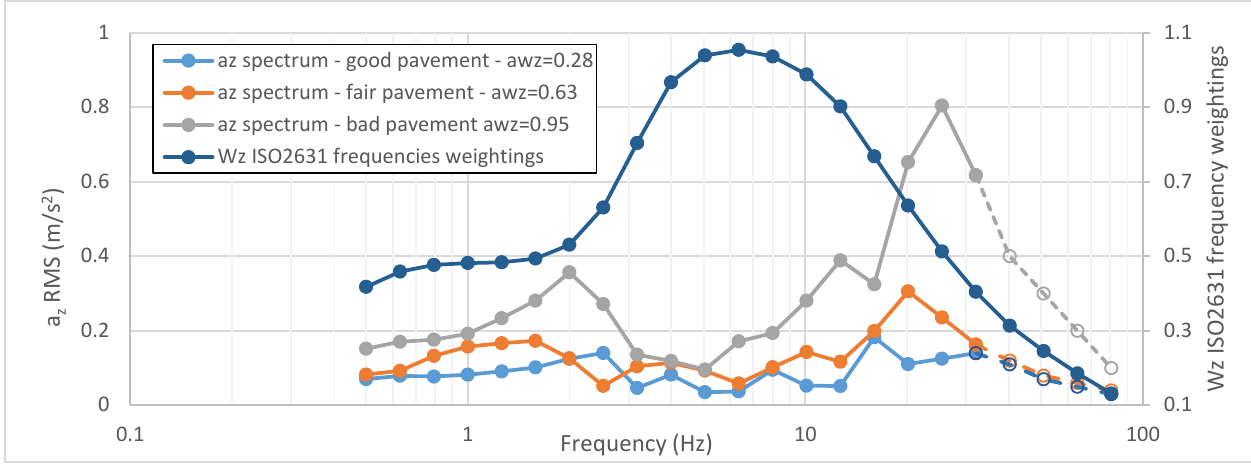
Figure 4. Three different spectra calculated starting from acceleration and ISO2631 frequencies weightings curve.